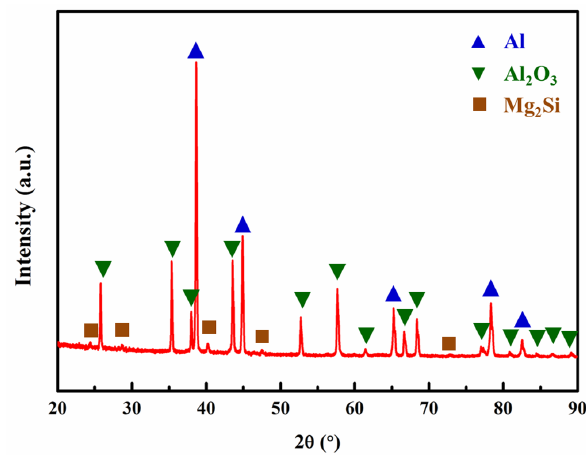
Figure 5: XRD analysis of the lamellar Al 2 O 3 p/Al composite.